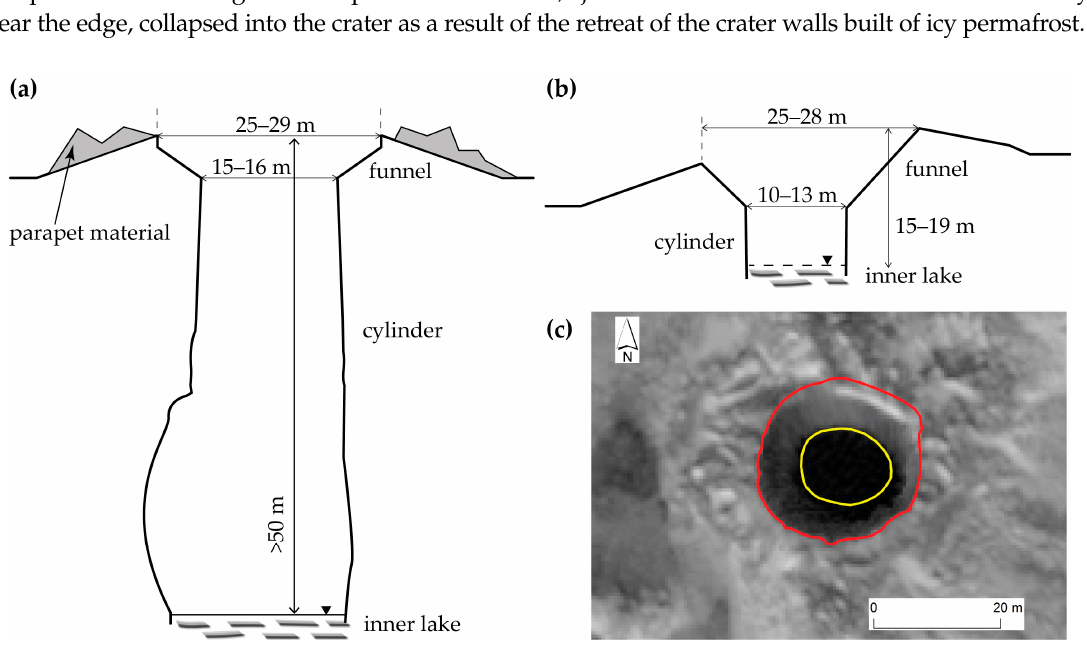
Figure 8. Differences in the structure of the studied craters: ( a ) GEC-1 at the time of the first field survey on 16 July 2014; ( b ) AntGEC as of the date of the satellite imagery acquisition on 11 October 2014; ( c ) the AntGEC crater edge (top of the funnel-shaped portion) position by the red line, the position of the cylindrical portion edge by the yellow line (WorldView-1 of 11 October 2014).